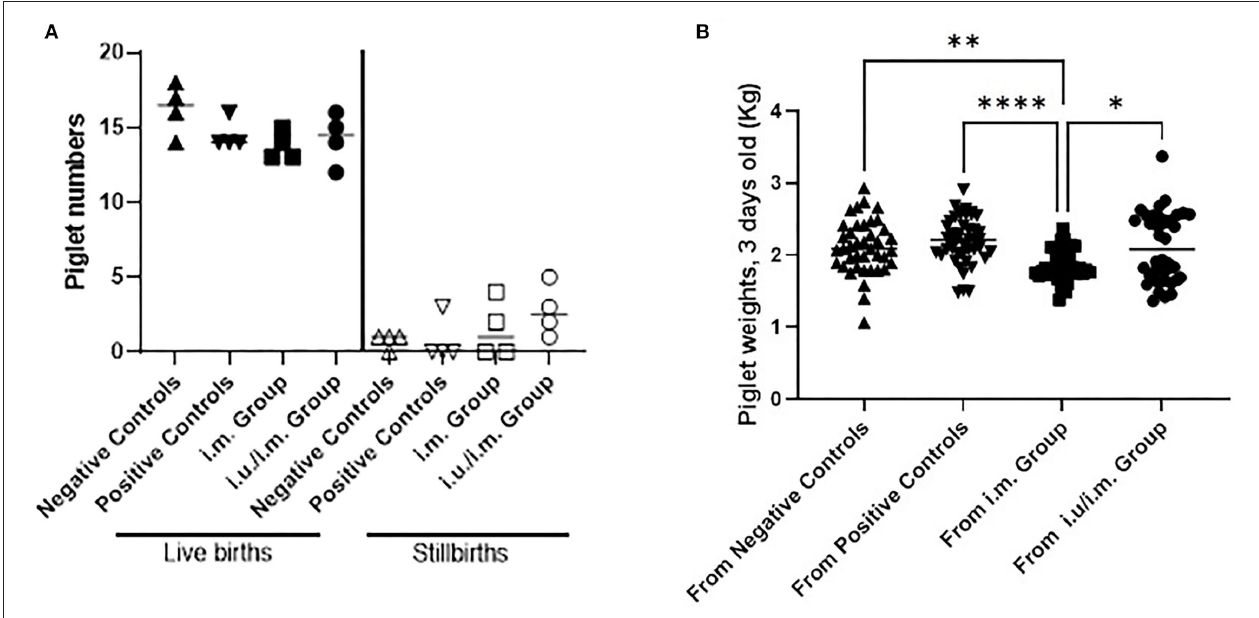
FIGURE 3 | Births and weights of piglets born to control gilts and gilts vaccinated through the intramuscular route with or without prior intrauterine vaccination. Gilts were immunized with PEDVS nanoparticle 30 days after estrus (i.m. group) or they were immunized via the intrauterine route at breeding and followed by an i.m. vaccine 30 days later (i.u./i.m. group). Negative control gilts did not receive any vaccine. Positive control gilts were previously immunized with a live attenuated PEDV vaccine and showed passive protection for piglets. (A) The number of live births per litter and the number of stillbirths per litter were recorded. Each symbol represents the number of piglets per gilt. The mean value is denoted by a horizontal bar with standard deviation indicated as error bars. (B) Piglets were weighed at 3 days of age (kg). Data are shown as the birth weights from all piglets born to each gilt with median weights shown by a horizontal line. Statistical comparisons were made between the control and vaccinated animals (A) and between all groups in (B) using the Kruskal-Wallis test and Dunn’s multiple comparisons test. Significant differences are denoted by different asterisks (* p < 0.05, ** p < 0.01, **** p < 0.0001).